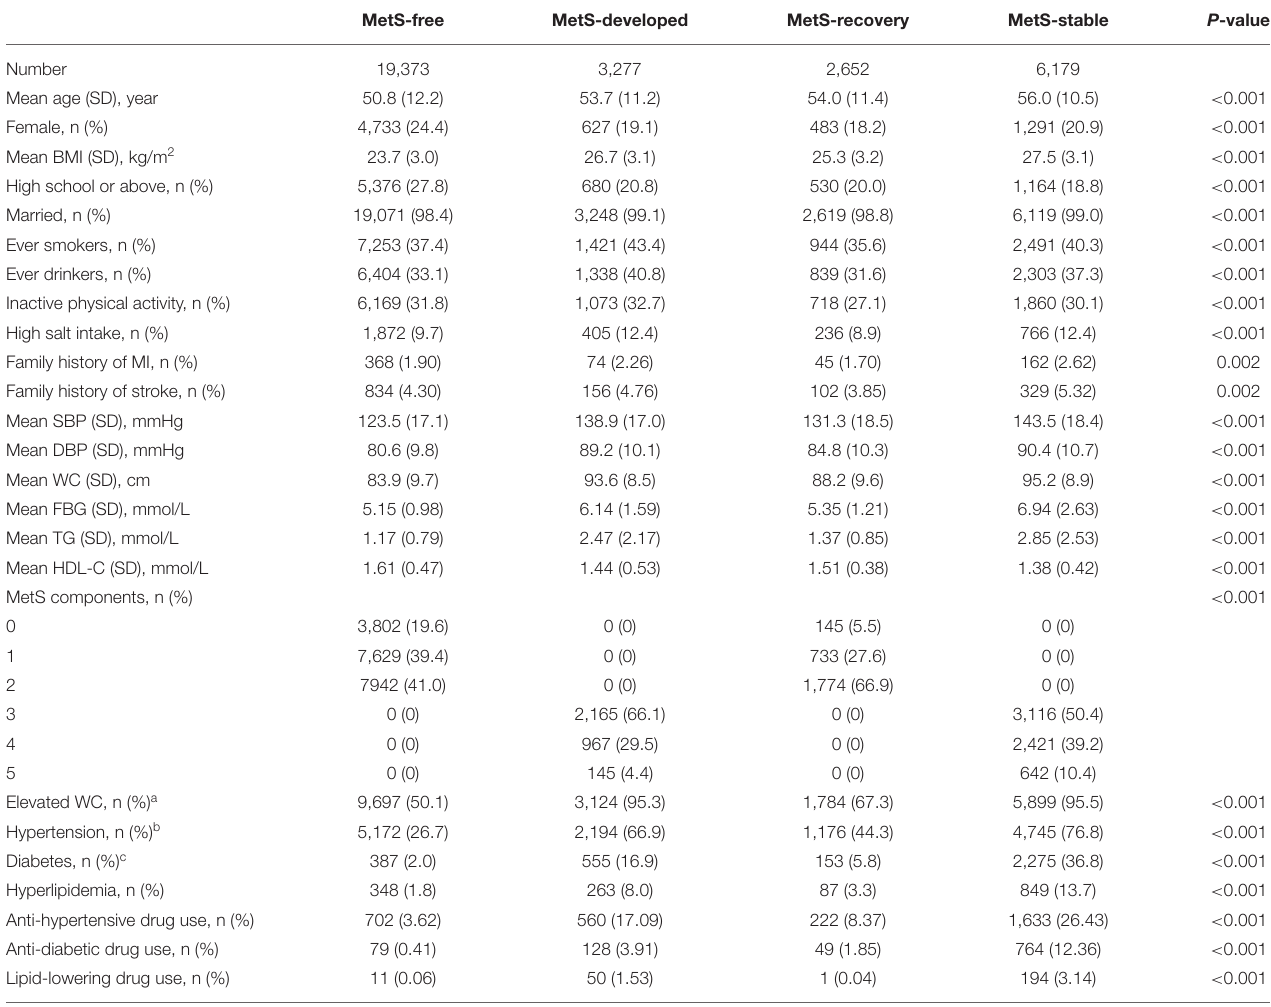
TABLE 1 | Baseline characteristics of subjects by the dynamic patterns of MetS in 2010. MetS-free MetS-developed MetS-recovery MetS-stable P